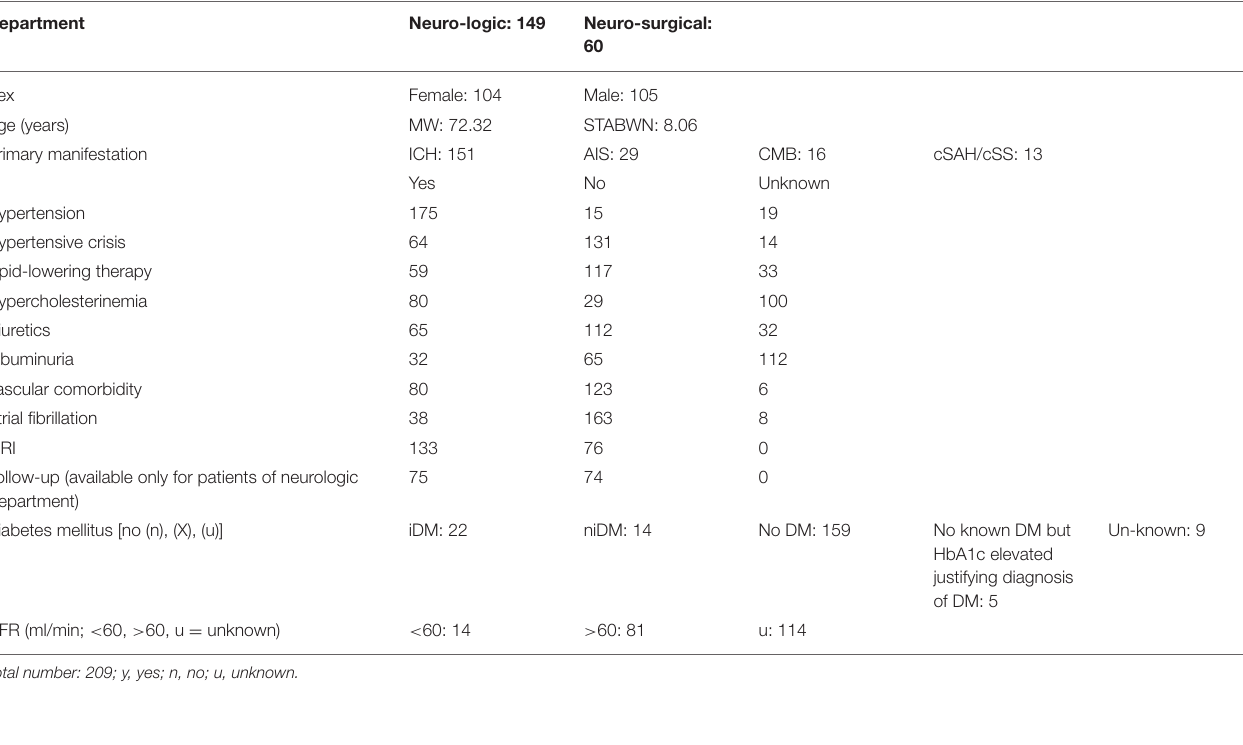
TABLE 1 | Patient characteristics.